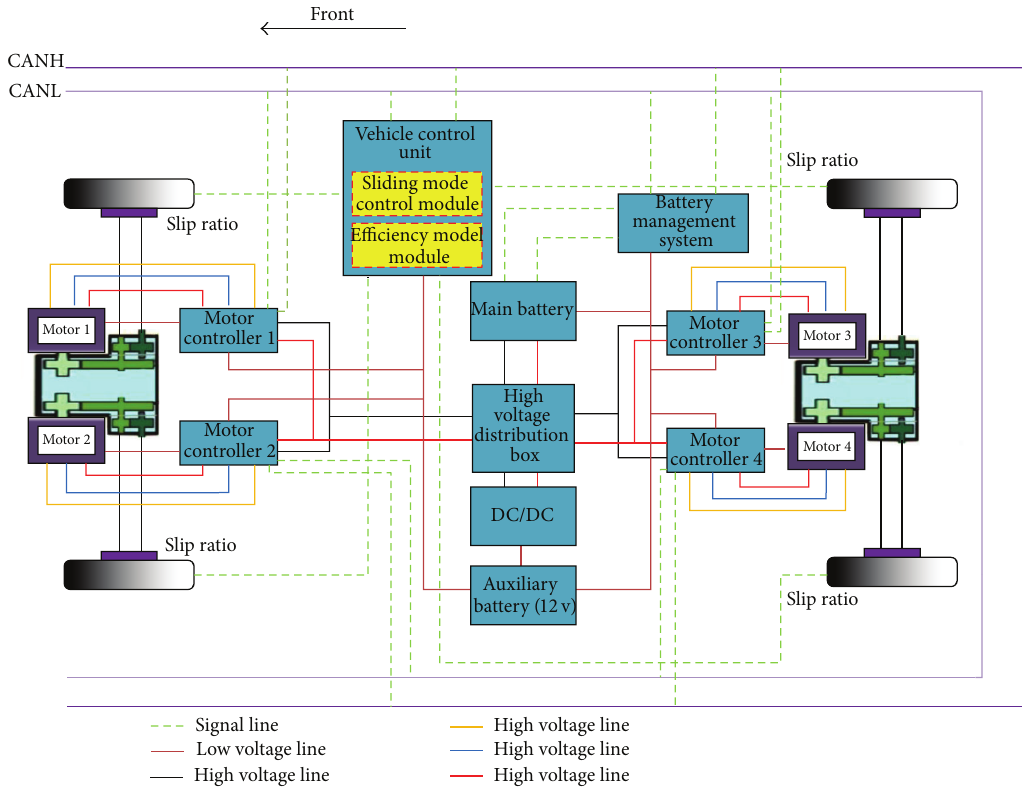
Figure 1: The vehicle